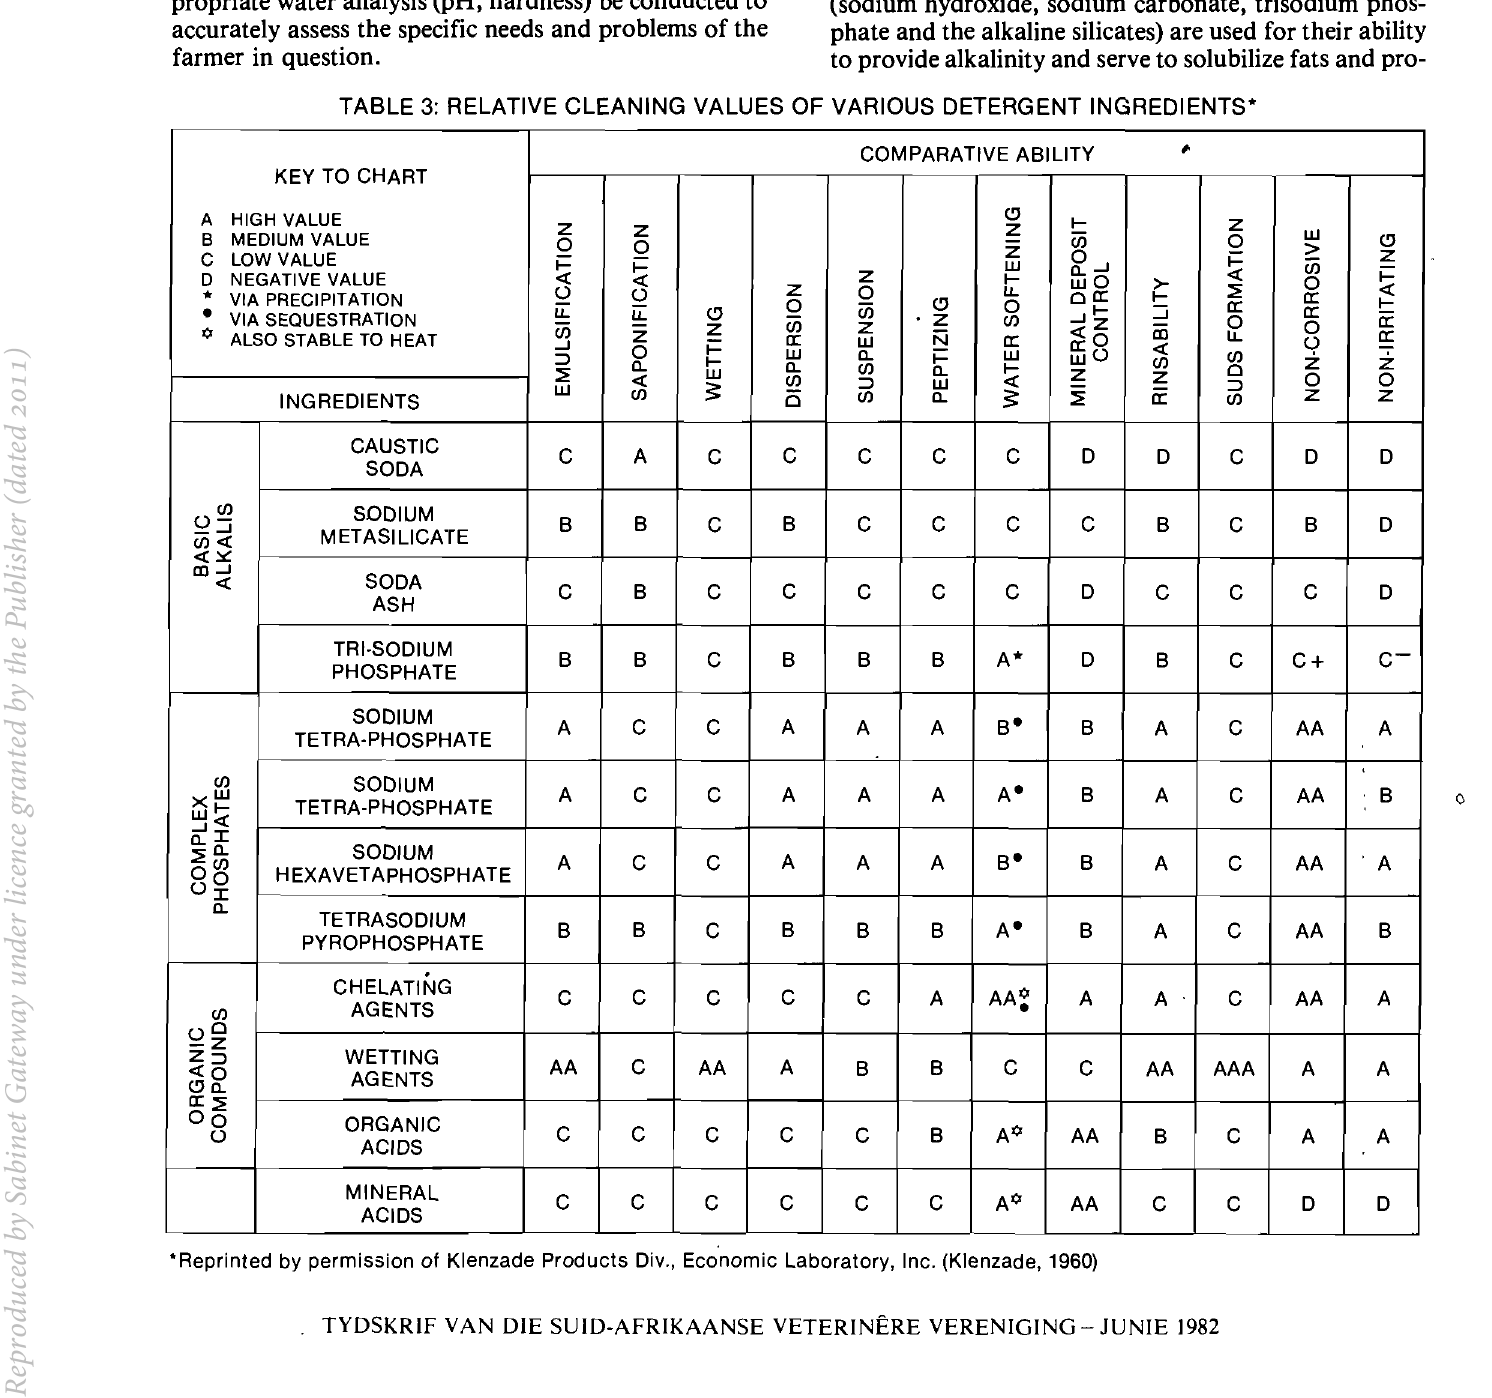
TABLE 3: RELATIVE CLEANING VALUES OF VARIOUS DETERGENT INGREDIENTS· COMPARATIVE